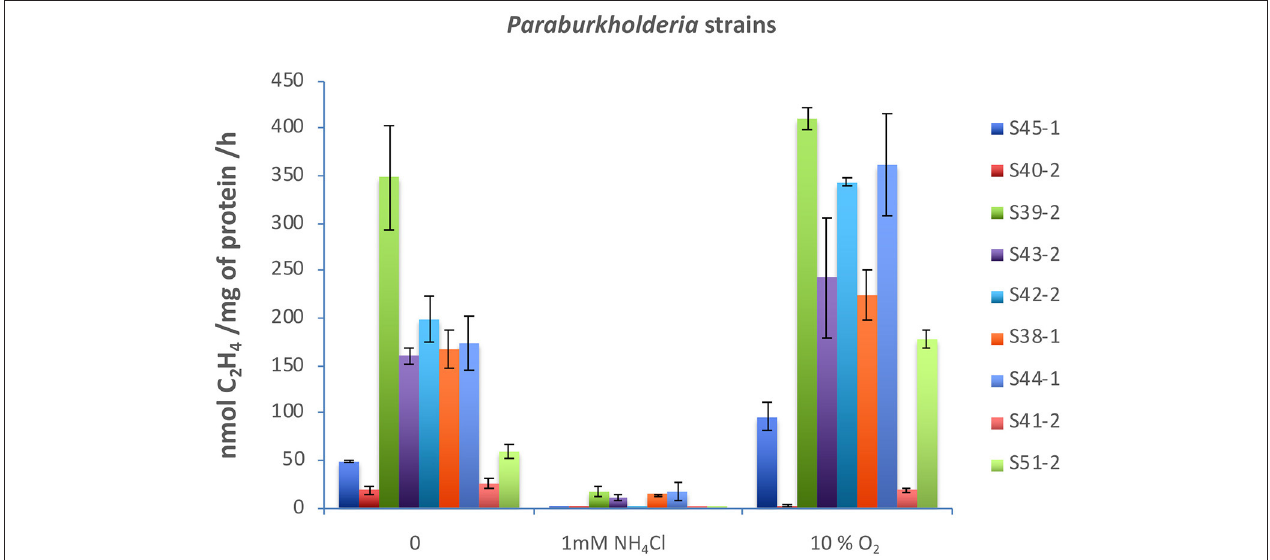
FIGURE 2 | Effects of NH + 4 (2mM) and O 2 (10%) on nitrogenase activity. All strains were incubated in 40ml of N-free medium in a 120ml vial at 30 ◦ C. NH + 4 was added to 2mM, and O 2 gas was injected to 10% v/v. Acetylene reduction assay was performed by injecting purified acetylene into the bottles sealed with gas-tight serum stoppers to yield 15% acetylene (v/v); this was followed by incubation for up to 96h at 30 ◦ C. Gas samples (0.5ml) were removed after incubation and analyzed by gas chromatography with a flame ionization detector and GS-alumina column. Paraburkholderia strains tested: S45-1, S40-2, S39-2, S43-2, S42-2, S38-1, S44-1, S41-2, and